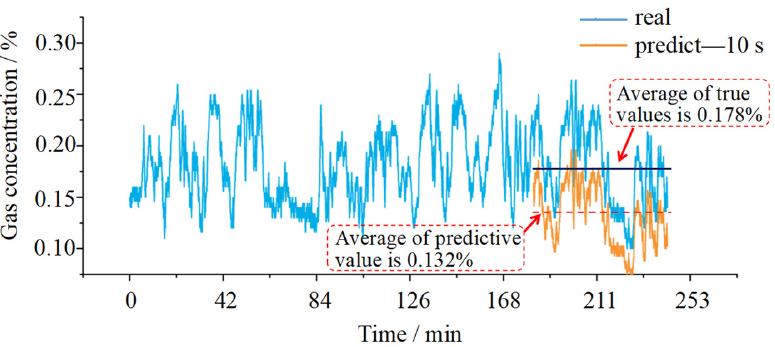
Figure 6. Gas concentration prediction of the model with an update period of 10 s.